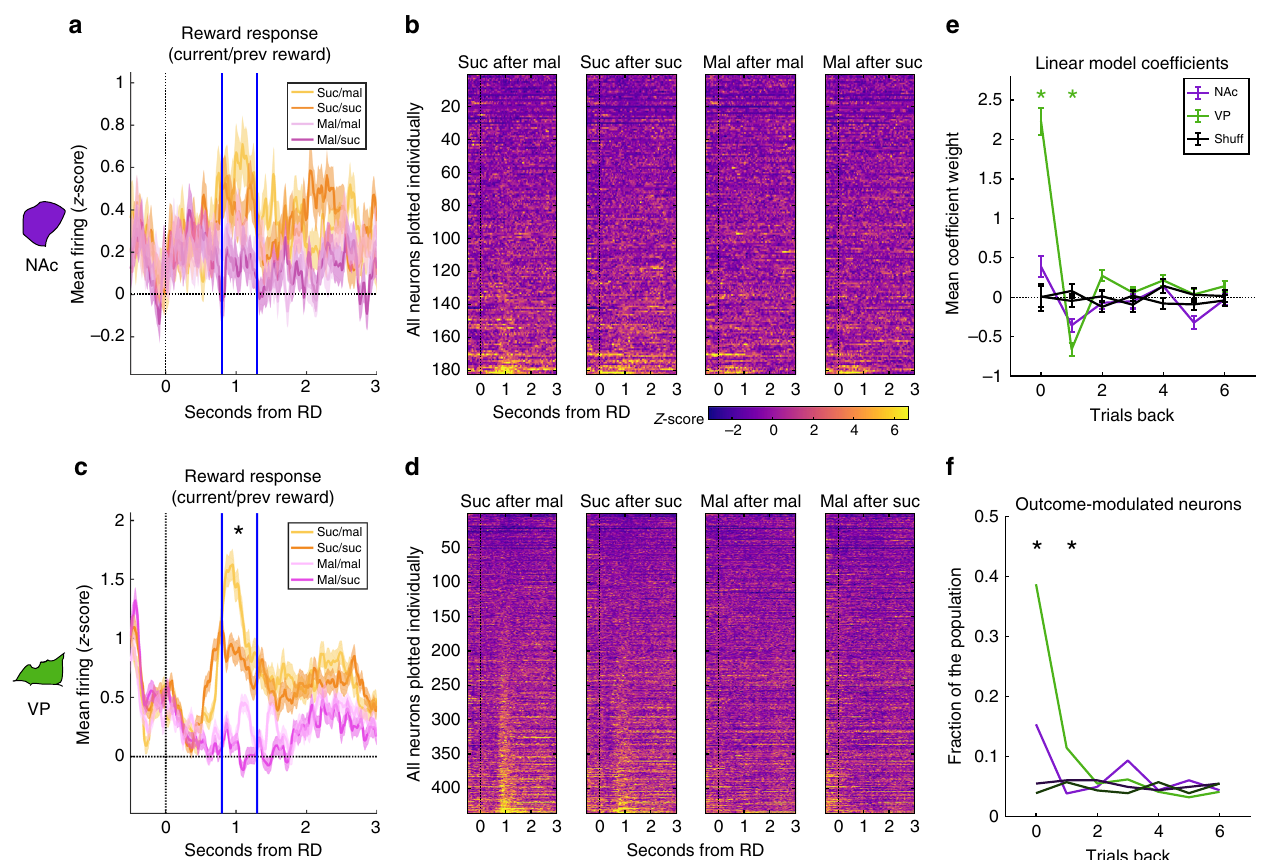
Fig. 4 Previous reward outcome impacts current reward fi ring. a , c Normalized activity of all neurons in NAc ( a ) and VP ( c ) on sucrose (orange) and maltodextrin (pink) trials of each reward, separated by reward outcome on preceding trial; darker lines indicate that sucrose was the prior trial ’ s reward. Asterisk indicates a signi fi cant main effect of previous reward on normalized fi ring rate in VP (F(1,1724) = 10.1, p = 0.022) for the epoch bounded by the vertical blue lines. b , d Normalized reward-related activity of every individual neuron in NAc ( b ) and VP ( d ) on trials with each combination of previous and current reward. e Mean coef fi cient weights for the impact of the current and previous 6 trials on normalized fi ring rate in the same epoch as ( a , c ) for each neuron in NAc (purple), VP (green), and corresponding data for each neuron with the outcomes shuf fl ed (black) for each region. Error bars are SEM. Asterisks are p < 0.05 for Tukey tests comparing VP coef fi cients to shuf fl ed data, corrected for multiple comparisons. f Proportion of the neural populations in VP (green), NAc (purple), and corresponding shuf fl ed neurons (black) with signi fi cant coef fi cients for each of the relative trials. Asterisks represent p < 0.05 for chi-square tests on both the distribution of neurons across all four conditions (true and shuf fl ed data from each region) and across the true